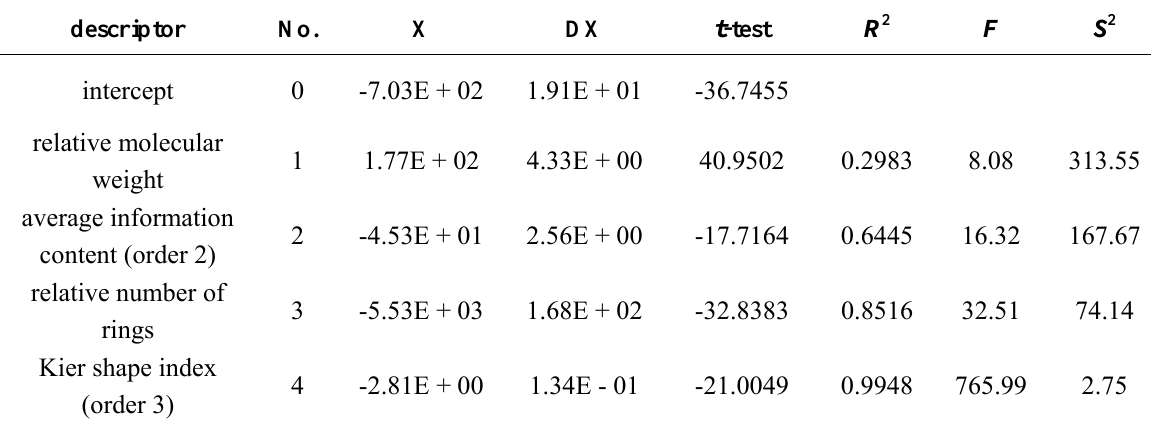
Table 1. Results of the best four-parameter multilinear regression for cloud point of nonionic surfactants based on the 20-member training